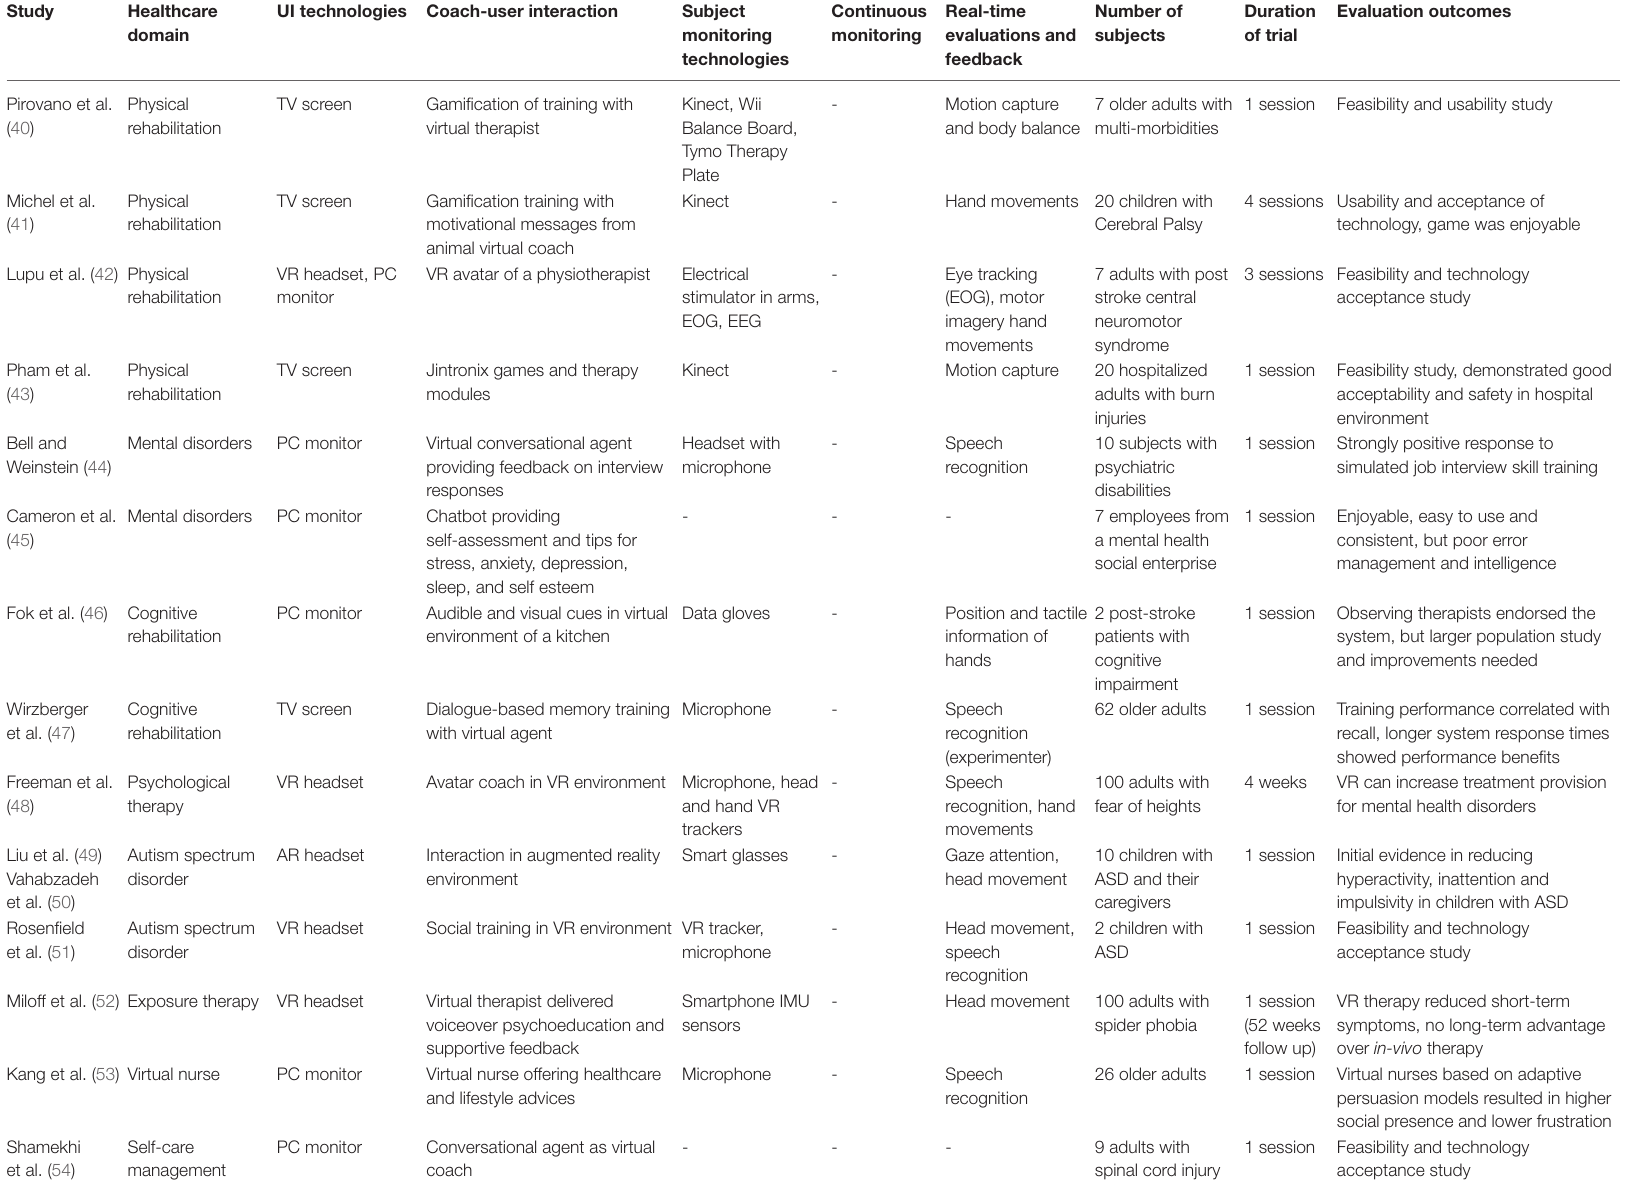
TABLE 2 | Coaching systems that were evaluated in controlled laboratory or clinical environment under direct